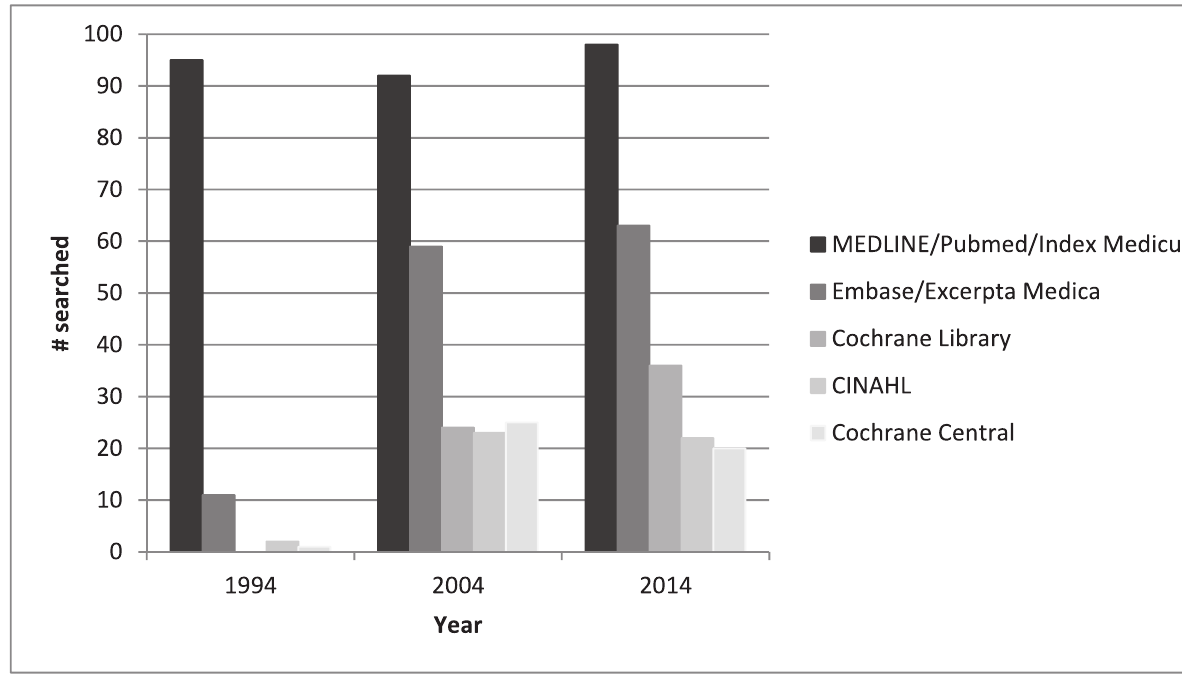
Most frequently used